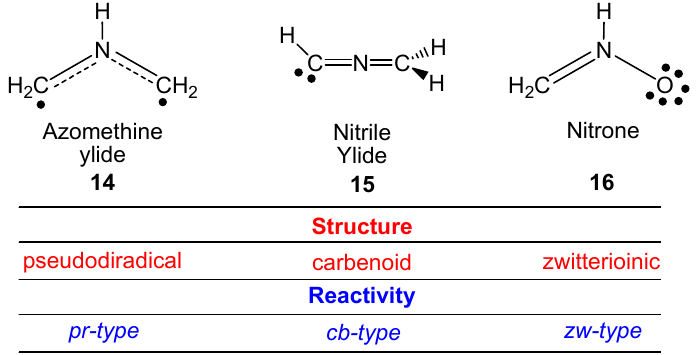
Scheme 3. Electronic structure of TACs and the proposed reactivity types in 32CA